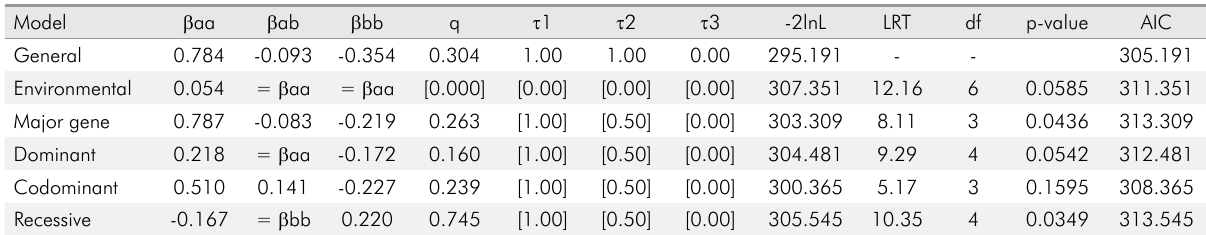
Table. Results of the segregation analysis performed for MIH. Values within square brackets were adjusted for calculation purposes.